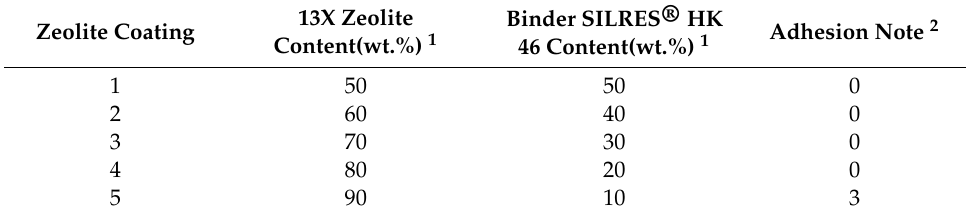
Table 2. Composition and adhesion note of zeolite coatings made with the 13X zeolite and the commercial binder SILRES ® HK 46 after thermal curing at 250 ◦ C for 30 min.